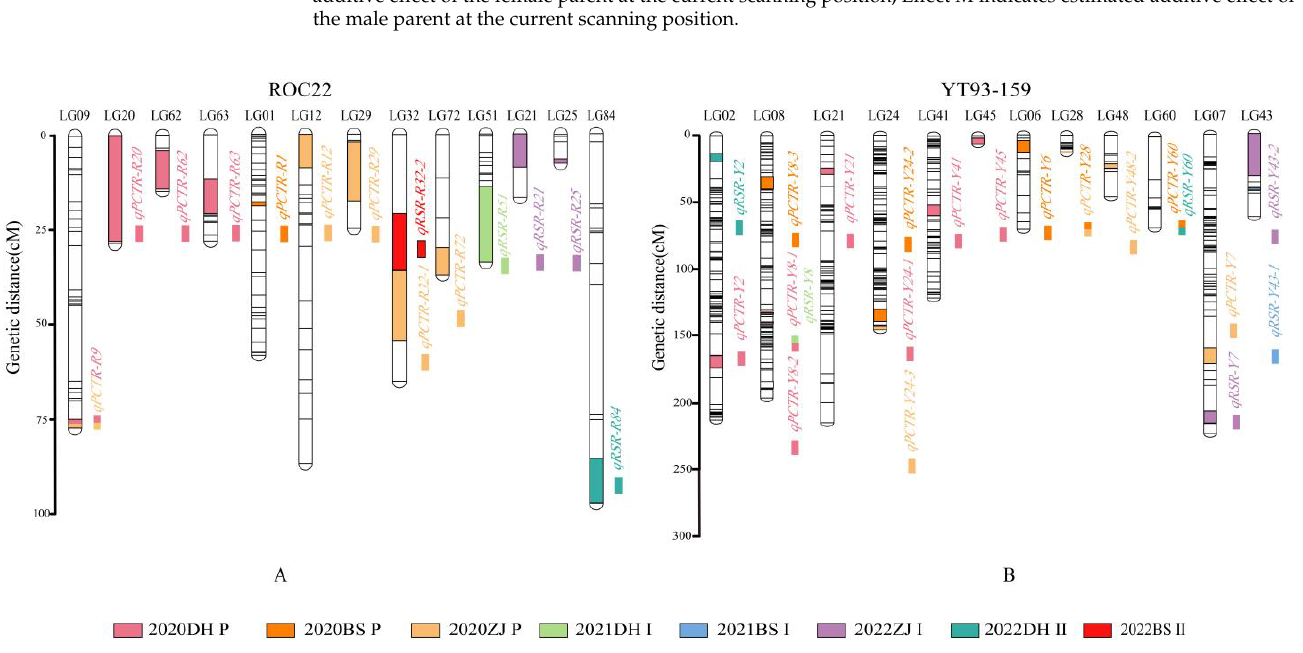
Figure 5. The distribution of the detected QTLs related to the plant crop tillering rate ( A ) and the ratoon sprouting rate ( B ) on sugarcane genetic linkage maps of the parents ROC22 and YT-93-159, respectively. LG, linkage group. Different colors in the figure represent different environments. Pink and orange represent the tillering rate of the plant cane in Dehong and Baise in 2020, respectively; yellow represents the tillering rate of the plant cane in Zhanjiang in 2021; pale green, blue and purple represent the first ratoon sprouting rate in Dehong, Baise and Zhanjiang in 2021, respectively; deep green and red represent the second ratoon sprouting rate in Dehong and Baise in 2022, respectively.